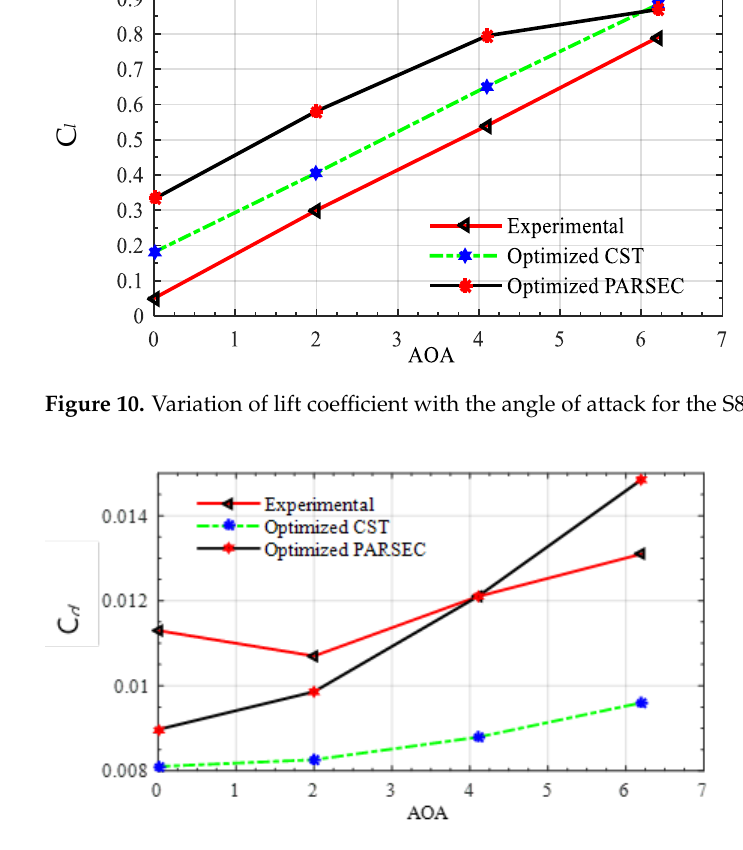
Figure 11. Variation of drag coefficient with the angle of attack for the S809 airfoil.